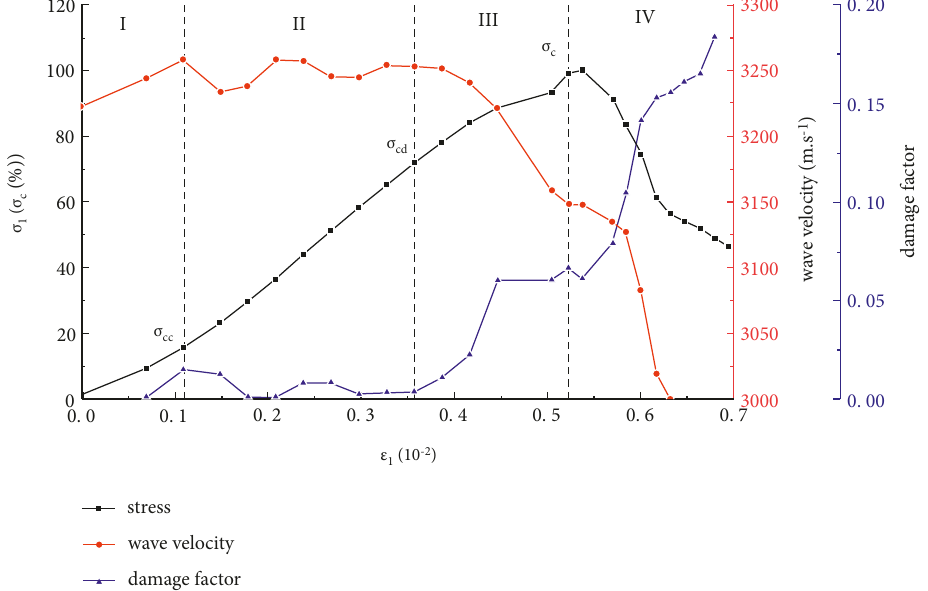
Figure 8: Relationships between ultrasonic wave velocity, damage, and